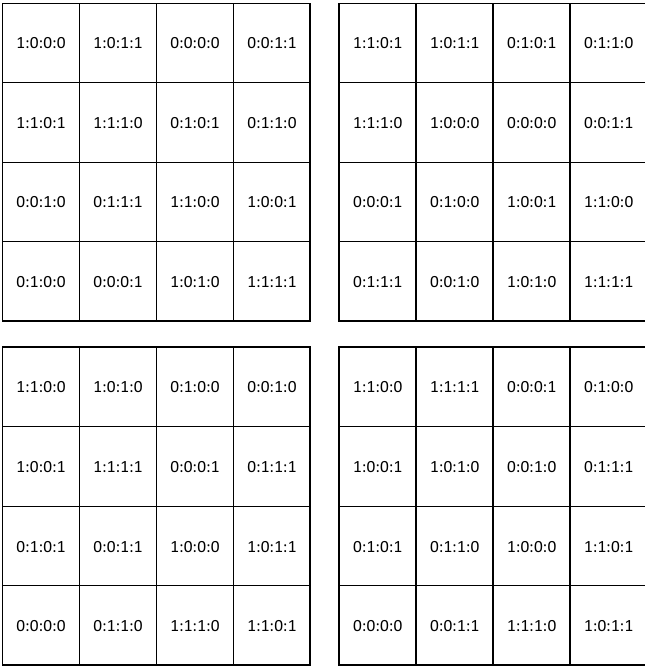
Figure 1. Design of the factorial experiment with 2 levels of four soil properties: pH, N, CaMg, and Mn (represented as pH:N:CaMg:Mn with a 0 for the low level and a 1 for the high level) with 4 replications of each treatment.